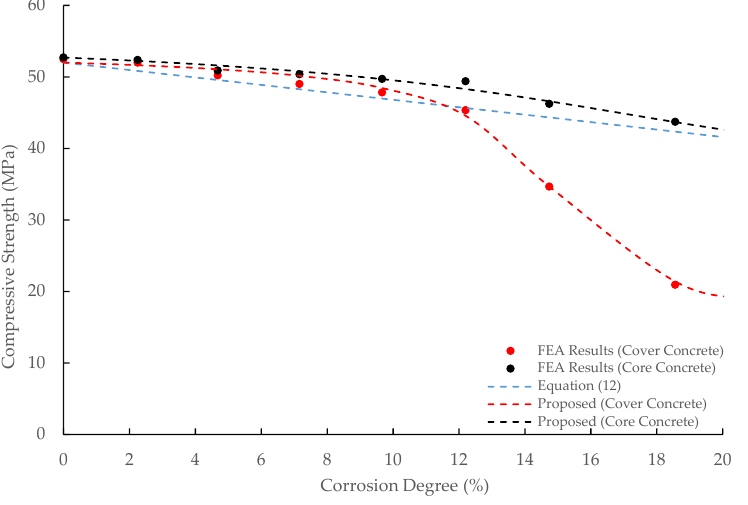
FEA Results (Cover Concrete) FEA Results (Core Concrete) Equation (12) Proposed (Cover Concrete) Proposed (Core Concrete)